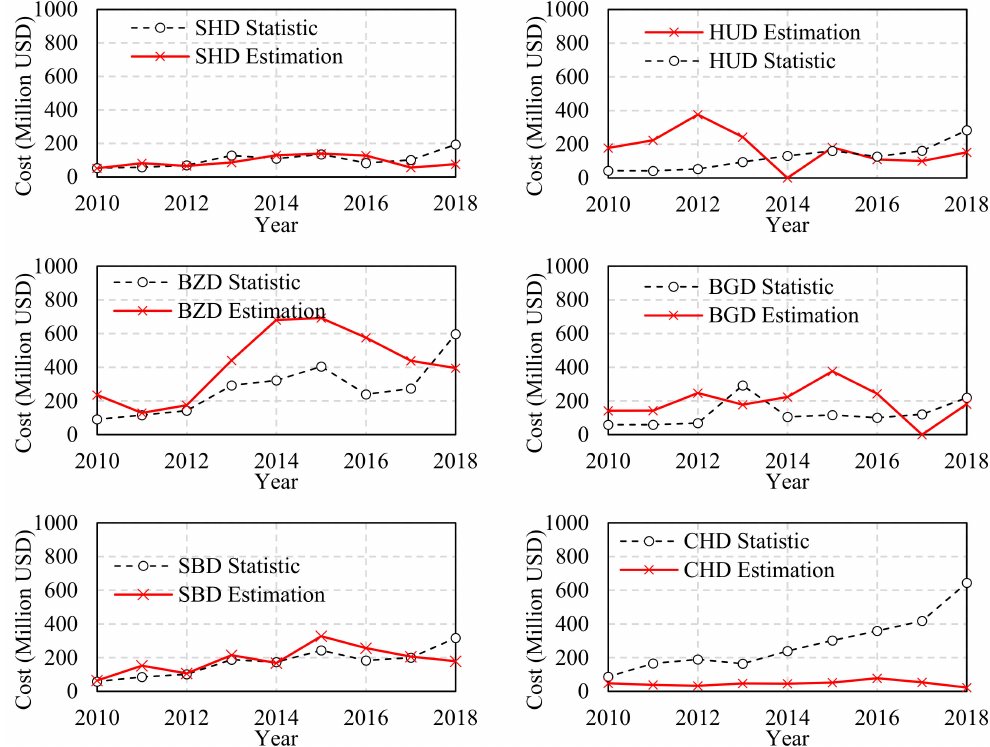
Figure 8. Comparison of cost estimation and statistical data of central district of Ulaanbaatar year by year. SHD: Songinokhairkhan district, HUD: Khan-Uul district, BZD-Bayanzurkh district, BGD: Bayangol district, SBD: Sukhbaatar district, CHD: Chingeltei